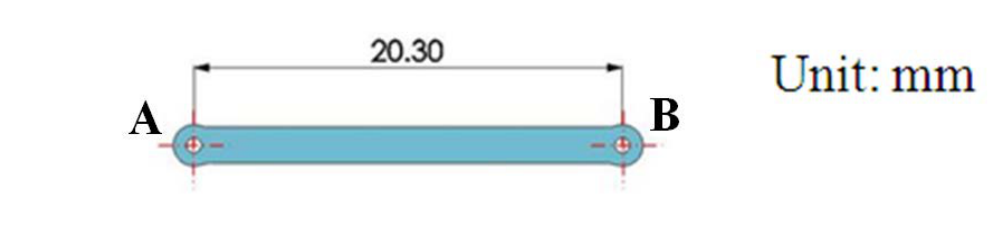
Figure 5. The measurement points for each part of the flapping-wing MAV.